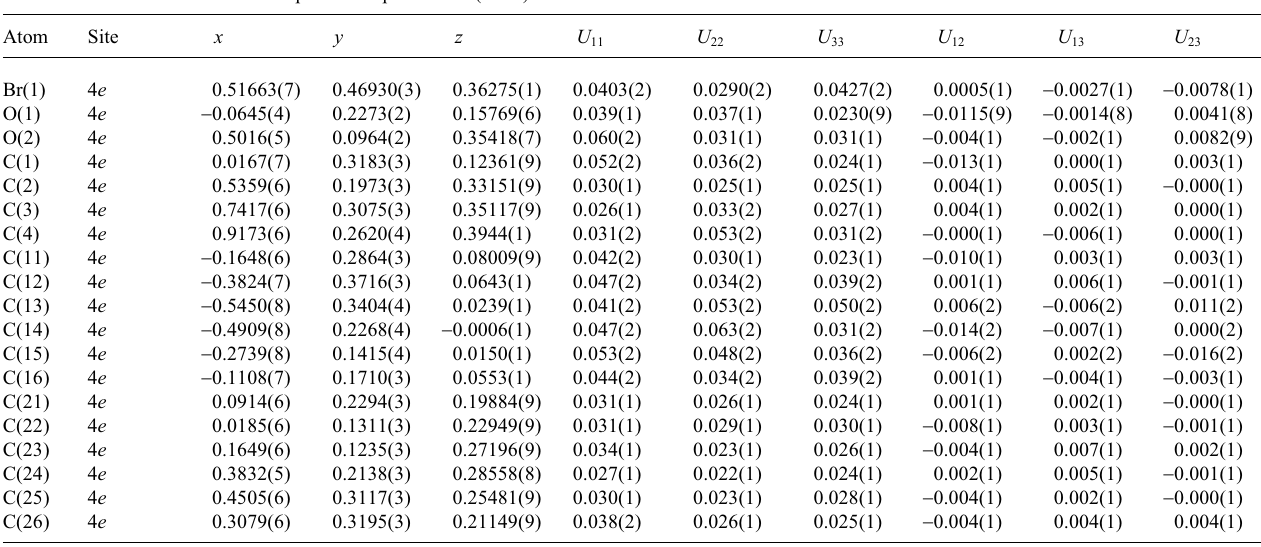
Table 3. Atomic coordinates and displacement parameters (in Å 2 )